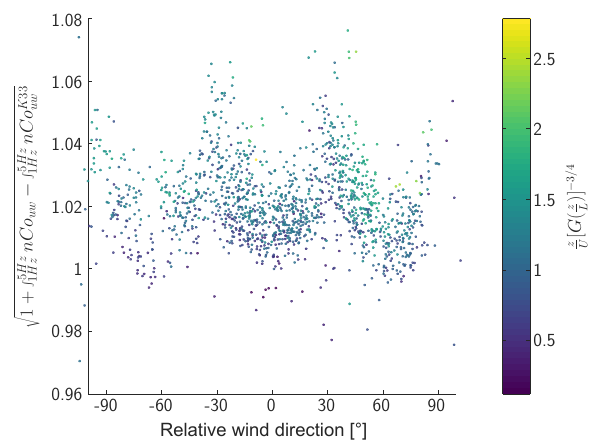
Figure B3. Overestimation of u ∗ due to elevated cospectral den- sity observed at n (cid:62) 1Hz estimated by comparing nCo uw (n ≥ 1Hz ) with Eq. (A1) as a function of the relative wind direction and the value of the non-dimensional frequency f n = 1Hz corresponding to n =